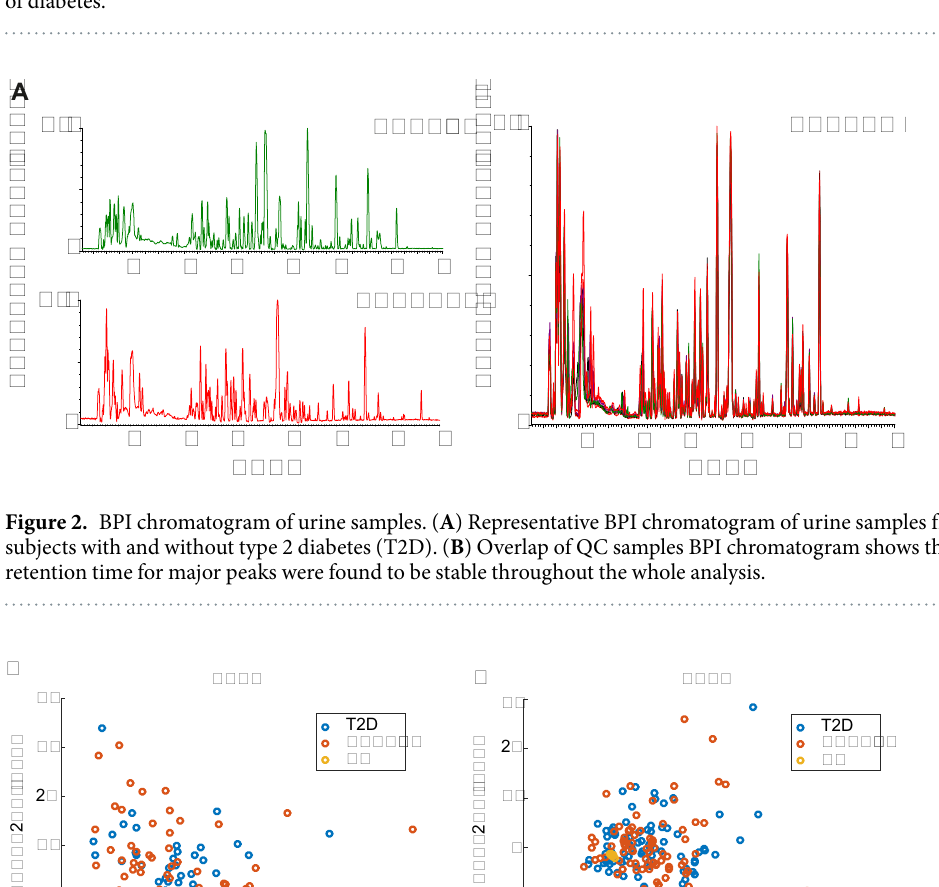
Figure 1. Workflow for untargeted metabolomics. Samples collected from nested case control cohort were prepared before being analyzed on UPLC-MS machines. After data preprocessing and data analysis, the metabolite biomarkers were validated using standards. The results are then compared to published biomarkers of diabetes.